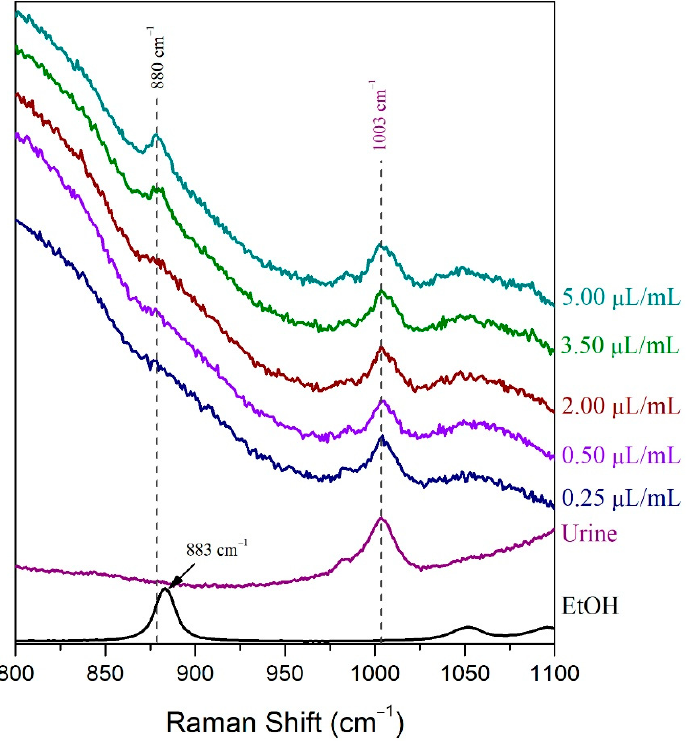
Figure 5. The LoD of ethanol in human urine using the method of cuvette was determined by visual evaluation. Table 2. The LoD of ethanol in human urine for the method of cuvette was determined based on the signal-to-noise ratio.